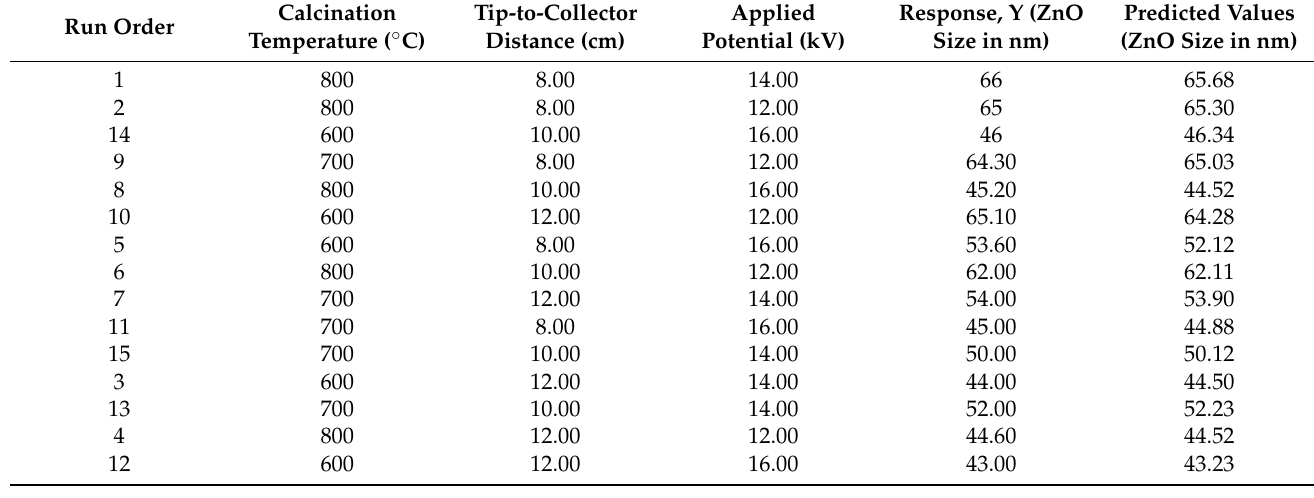
Table 3. Box–Behnken design matrix containing 15 experimental runs.